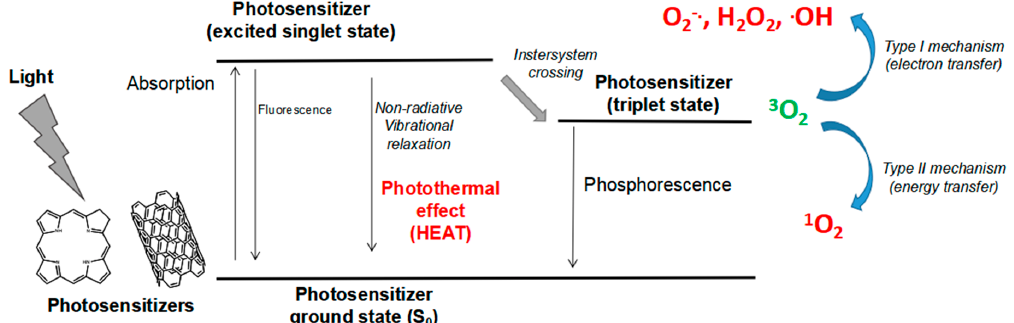
Figure 2. Simplified Jablonski diagram depicting the different energy levels induced after light irradiation. The phototherapeutic agent (photosensitizer) is excited from ground level (S 0 ) to the singlet excited state, where it may lose its absorbed energy through fluorescence or non-radiative reactions. Effective agents undergo intersystem crossing and conversion into the triplet excited state, which enables photoreactions to take place [24].